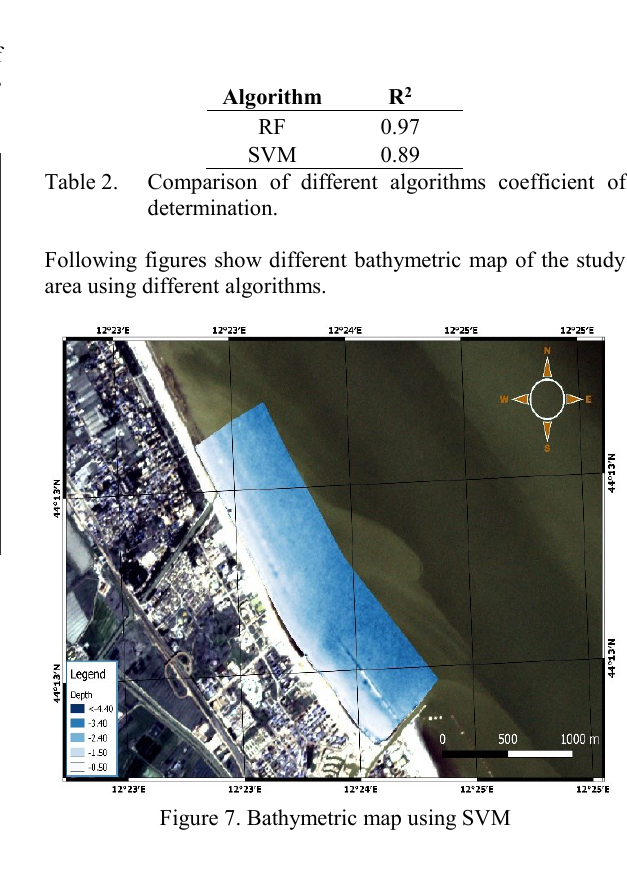
Table 1. Comparison of ML algorithms results